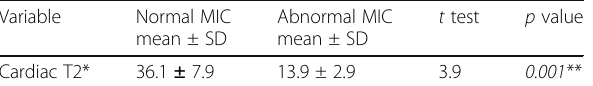
Table 4 Correlation between serum ferritin, hepatic, and cardiac investigations of the studied group Variable